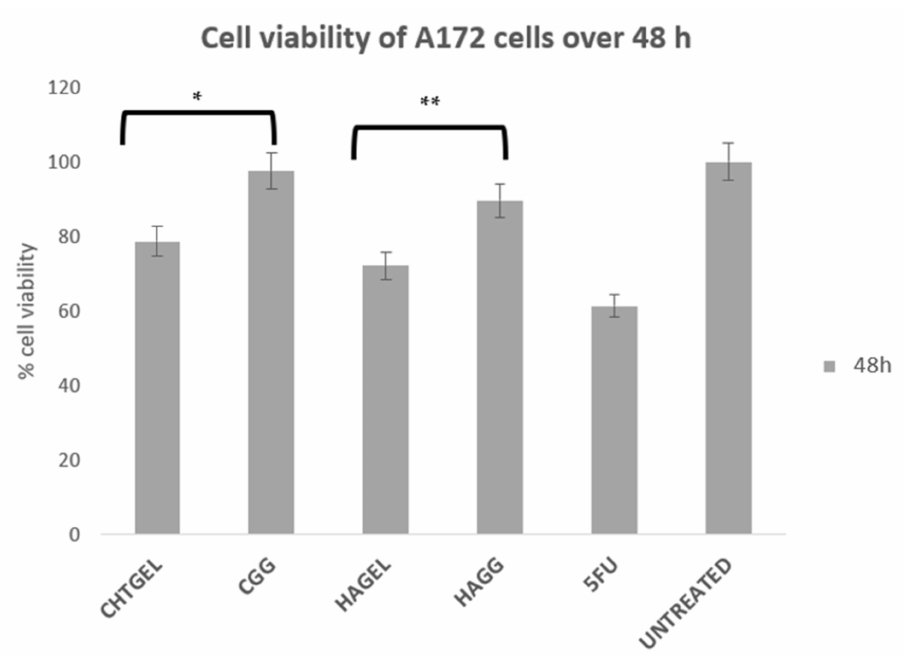
Figure 14. Cytotoxicity analysis of the crosslinked and uncrosslinked formulations, carried out on A172 cells over 48 h using an XTT cell viability assay (SD < 0.3) (n = 3). 5-FU (5-Fluorouracil, 10 µ g/mL) was used as the positive control (* p = 0.0009, ** p =